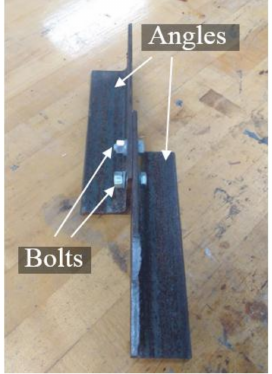
Figure 17. The test specimen placed on a table.